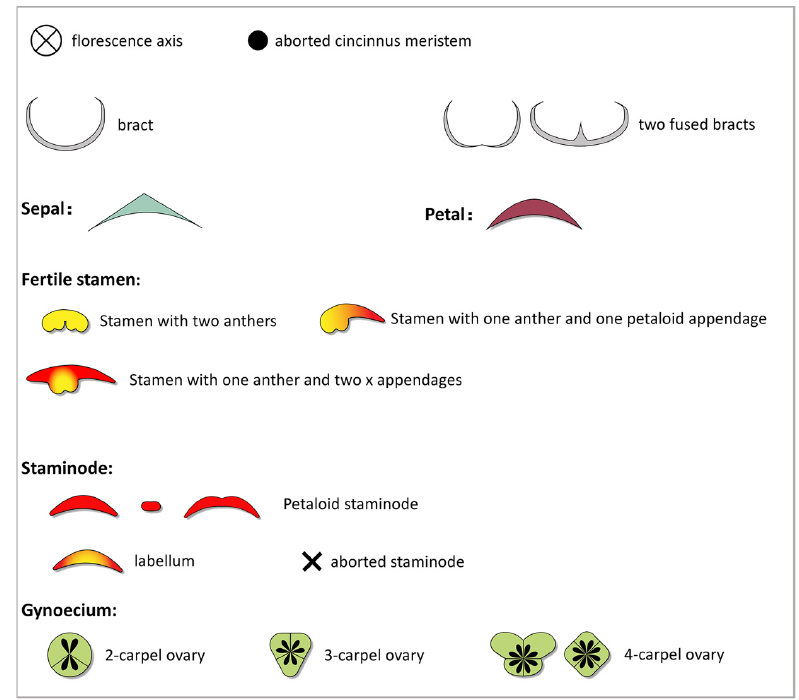
Figure 2. Symbols and their descriptions for floral diagrams.